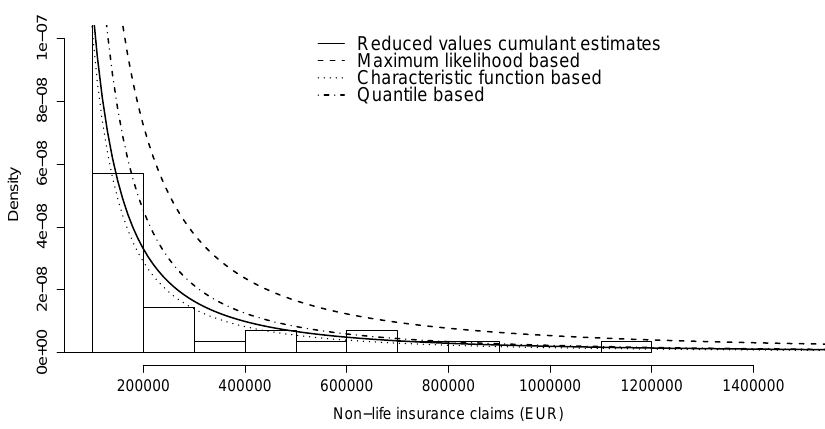
Figure 2. Modelling non-life insurance losses ( n = 2802) via stable distributions (Table